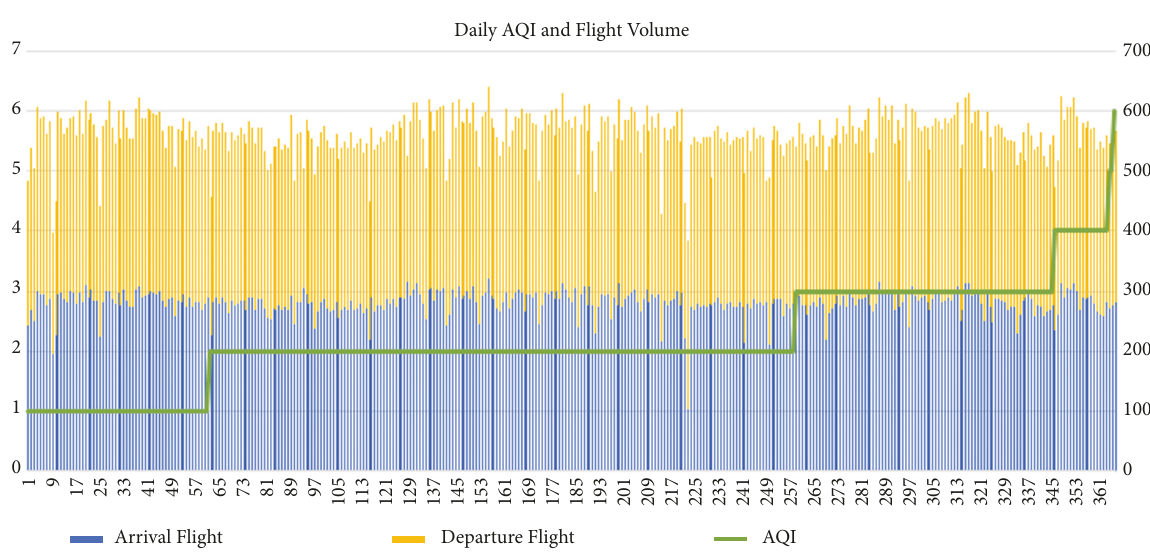
Figure 3: Daily AQI and flight volume for ZSNJ in 2017.